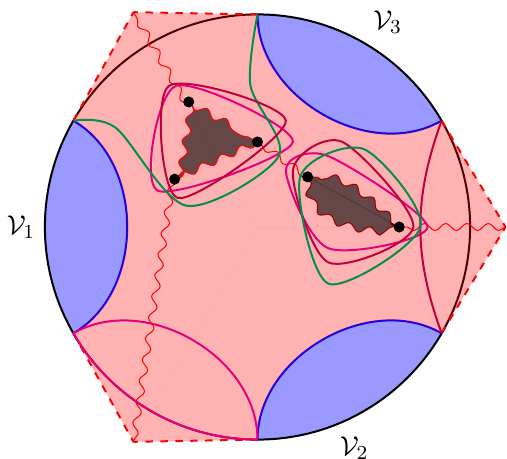
Figure 17. An example of a focusing lightsheet in a spacetime that contains two singularities. The singularities are regions of the bulk where the lightsheet ends. The curves where the three past lightsheets P P P intersect F are drawn in three distinct colors. Each of these has an open 1 , 2 , 3 component (the dividing curve), and lightsheets P lightsheet P has only a single closed component. The left singularity is separated from γ 3 dividing curve α , while the right singularity is only separated from γ 3